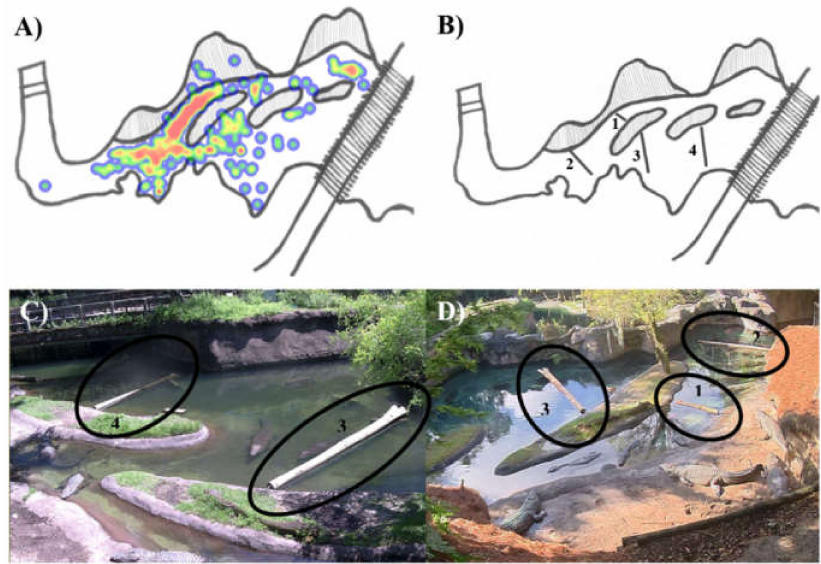
Figure 1. ( A ) Heatmap depicting the locations of agonistic interactions observed in April and May 2020. Locations highlighted in red are more frequent locations of agonism. Locations highlighted in green and dark blue are less-frequent locations of agonism. Heatmap generated using the ZooMon- itor application [38]. ( B ) Map of exhibit highlighting placement of visual barriers (labeled 1–4). ( C , D ) Images of exhibit with visual barriers